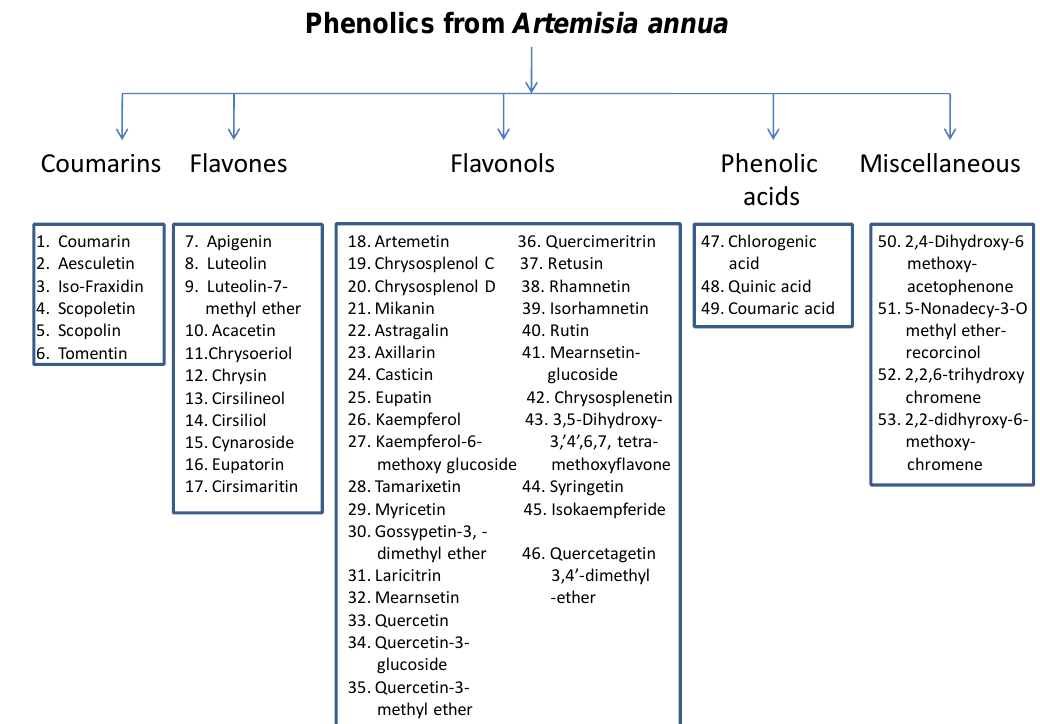
Figure 2 . Major phenolics from Artemisia annua , with the great majority being flavones or